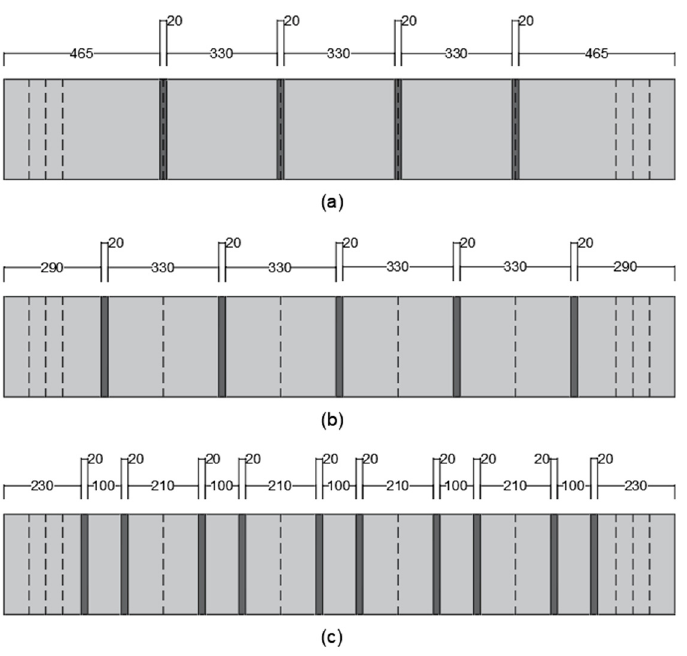
Figure 3. Details of NSM ‐ CFRP configurations: ( a ) aligned NSM ‐ CFRP, ( b ) one unaligned NSM ‐ CFRP strip, and ( c ) two unaligned NSM ‐ CFRP strips (units: mm).